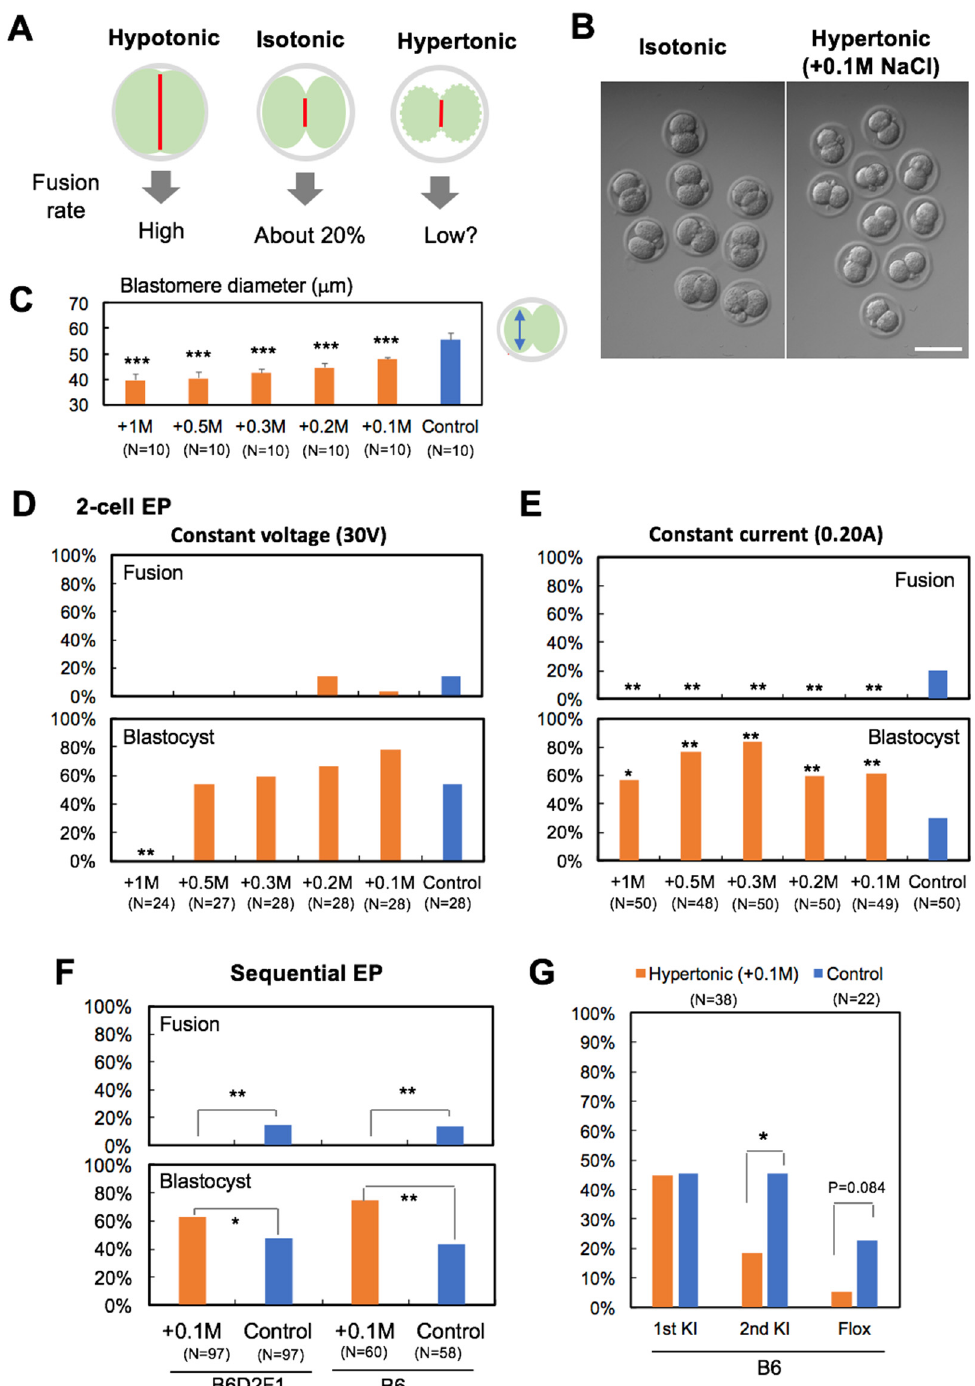
Figure 2. Effects of hypertonic treatment on blastomere fusion, embryonic development and KI efficiency of 2-cell stage embryos. ( A ) Expected relationship between tonicity and cell fusion. ( B ) Morphology of 2-cell stage embryos (B6D2F1) after 20 min treatment of isotonic or hypertonic EP buffer. ( C ) Blastomere diameter under hypertonic conditions. ( D ) Fusion and development (blastocyst) rate of 2-cell EP embryos under constant voltage. ( E ) EP under constant current. ( F ) Fusion and development (blastocyst) rate of 2-cell stage embryos after sequential EP under constant current. ( G ) KI efficiency of blastocysts by sequential EP under hypertonic or isotonic conditions. N indicates the number of 2-cell stage embryos ( D – F ) and blastocysts ( G ) used for the analysis. * p < 0.05, ** p < 0.01, *** p < 0.001 (compared with control). Scale bar, 100 μ m.